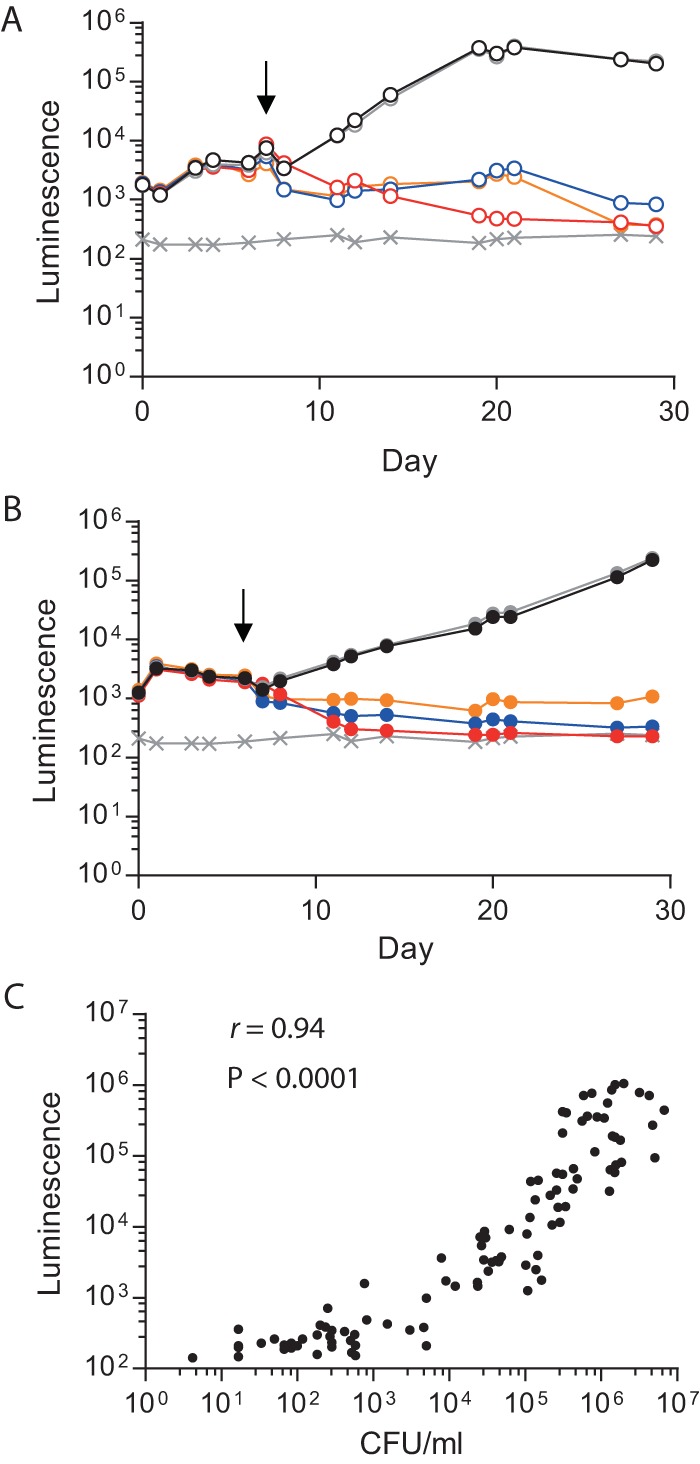
Effects of standard antituberculosis antibiotics on M. tuberculosis growth. Antibiotics (rifampin [red, 1 µg/ml], INH [blue, 0.25 µg/ml], and ethambutol [orange, 4 µg/ml]) were added at day 6 to 2D PBMC cultures or the microsphere system, and M. tuberculosis growth was monitored by measuring luminescence. M. tuberculosis growth was inhibited by all of the antibiotics in both 2D cell cultures (A) and the 3D model (B). M. tuberculosis growth was unaffected in the control sample (black) or by the addition of DMSO (gray), which was used as a solvent for rifampin. Symbols: ×, background level of luminescence; black arrows, antibiotic addition. Data are the mean ± the standard error of the mean of an experiment performed in triplicate and are representative of three separate experiments. (C) M. tuberculosis luminescence closely correlates with CFU counts on Middlebrook 7H11 agar. Spearman r value = 0.94; P < 0.0001.